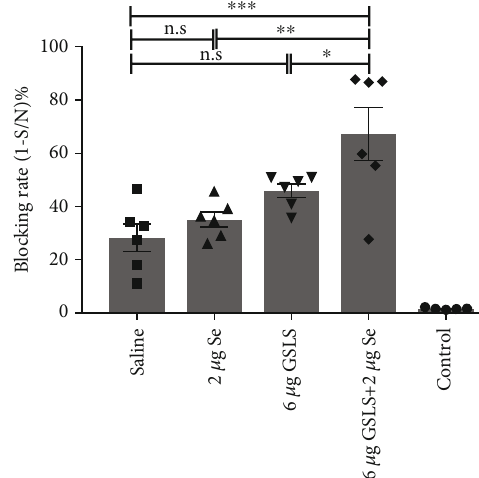
Figure 1: E ff ects of GSLS and/or Se on PrV gB-speci fi c IgG response. Mice ( n = 6 /group) received twice i.m. injections of an aPrV vaccine (1000 TCID ) in saline or saline with Se (2 μ g), 50 GSLS (6 μ g), or GSLS (6 μ g) mixed with Se (2 μ g) at two weeks apart. Sera were collected 1 week after the booster for analysis of PrV gB-speci fi c IgG by a blocking ELISA. Data are expressed as the mean ± SE . ∗ p < 0 : 05 , ∗∗ p < 0 : 01 , ∗∗∗ p < 0 : 001 , among the groups as indicated by one-way ANOVA with LSD